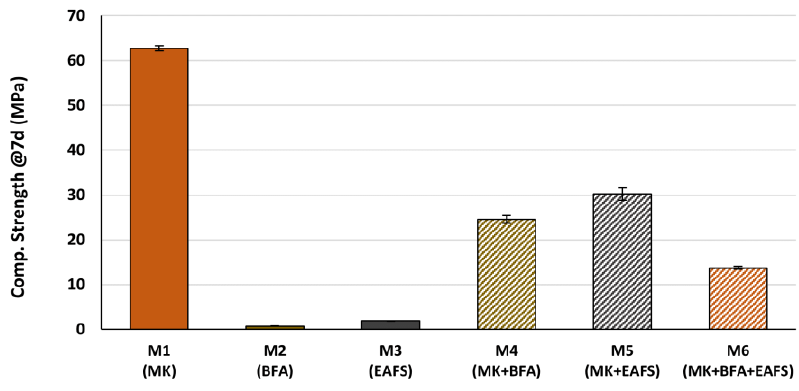
Figure 8. CS of GPC mortars after 7 days of curing.